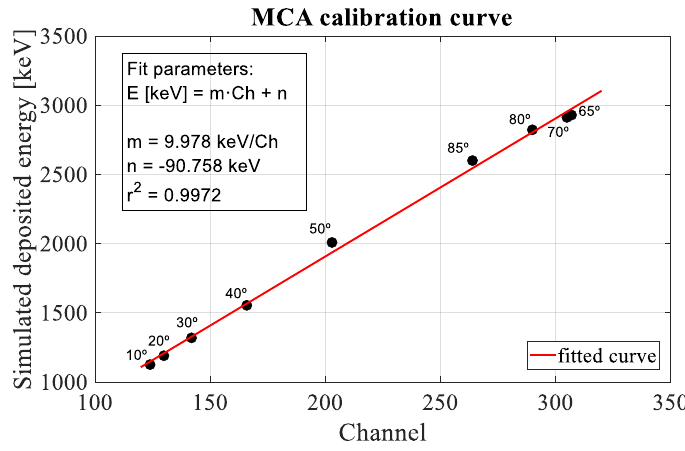
Figure 9. MCA calibration curve obtained by plotting the most probable value of the deposited energies at different angles simulated by the SRIM 2013 code against the experimental channels and calculating the line of best fit.